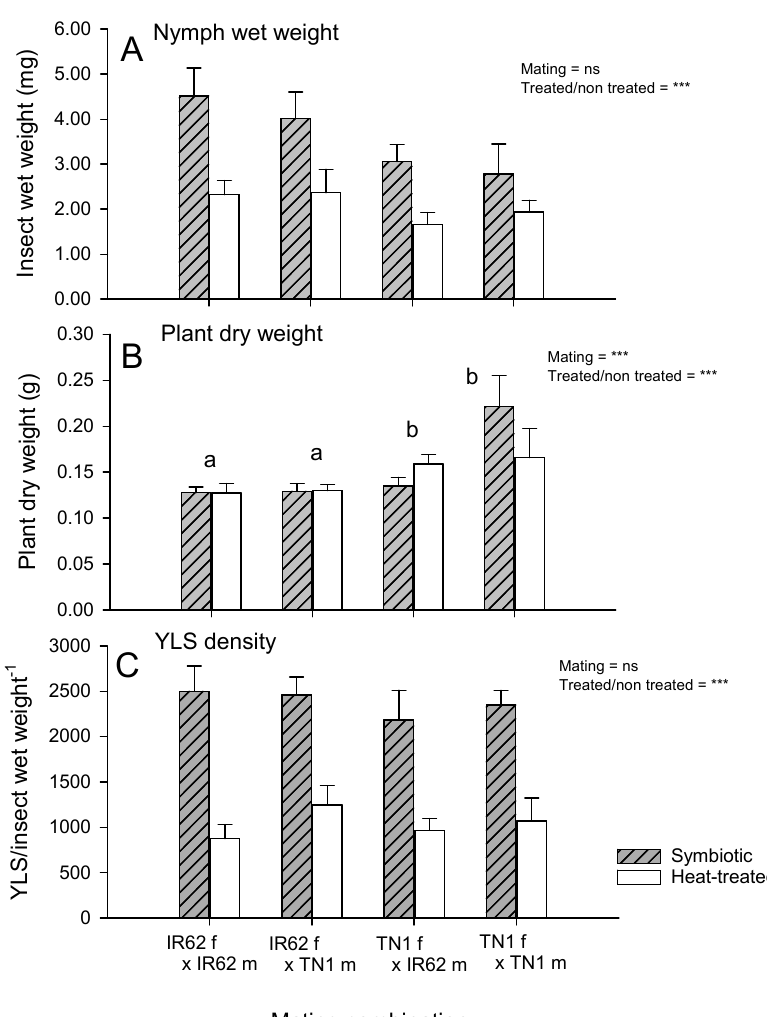
Figure 4. ( A ) Wet weight of unmated adult females (F1) derived from controlled mating between virulent and avirulent planthoppers with ( B ) the corresponding final weights of IR62 seedlings after planthopper feeding. ( C ) The estimated densities of YLS at the end of the experiment are also presented. Gray bars represent symbiotic planthoppers and white bars represent aposymbiotic planthoppers. Standard errors are indicated (N = 12). NS = no significant effect, *** = highly significant effect ( p < 0.001). Lowercase letters indicate homogenous groups (Tukey p > 0.05). Data were log-transformed before analyses.